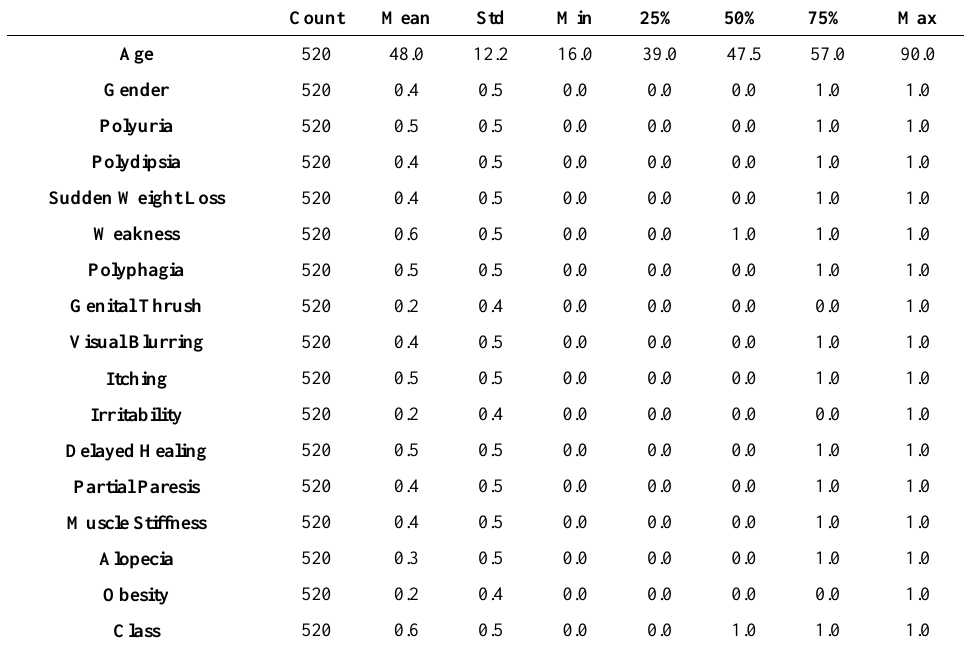
Table 4. The descriptive statistics of the early-stage diabetes